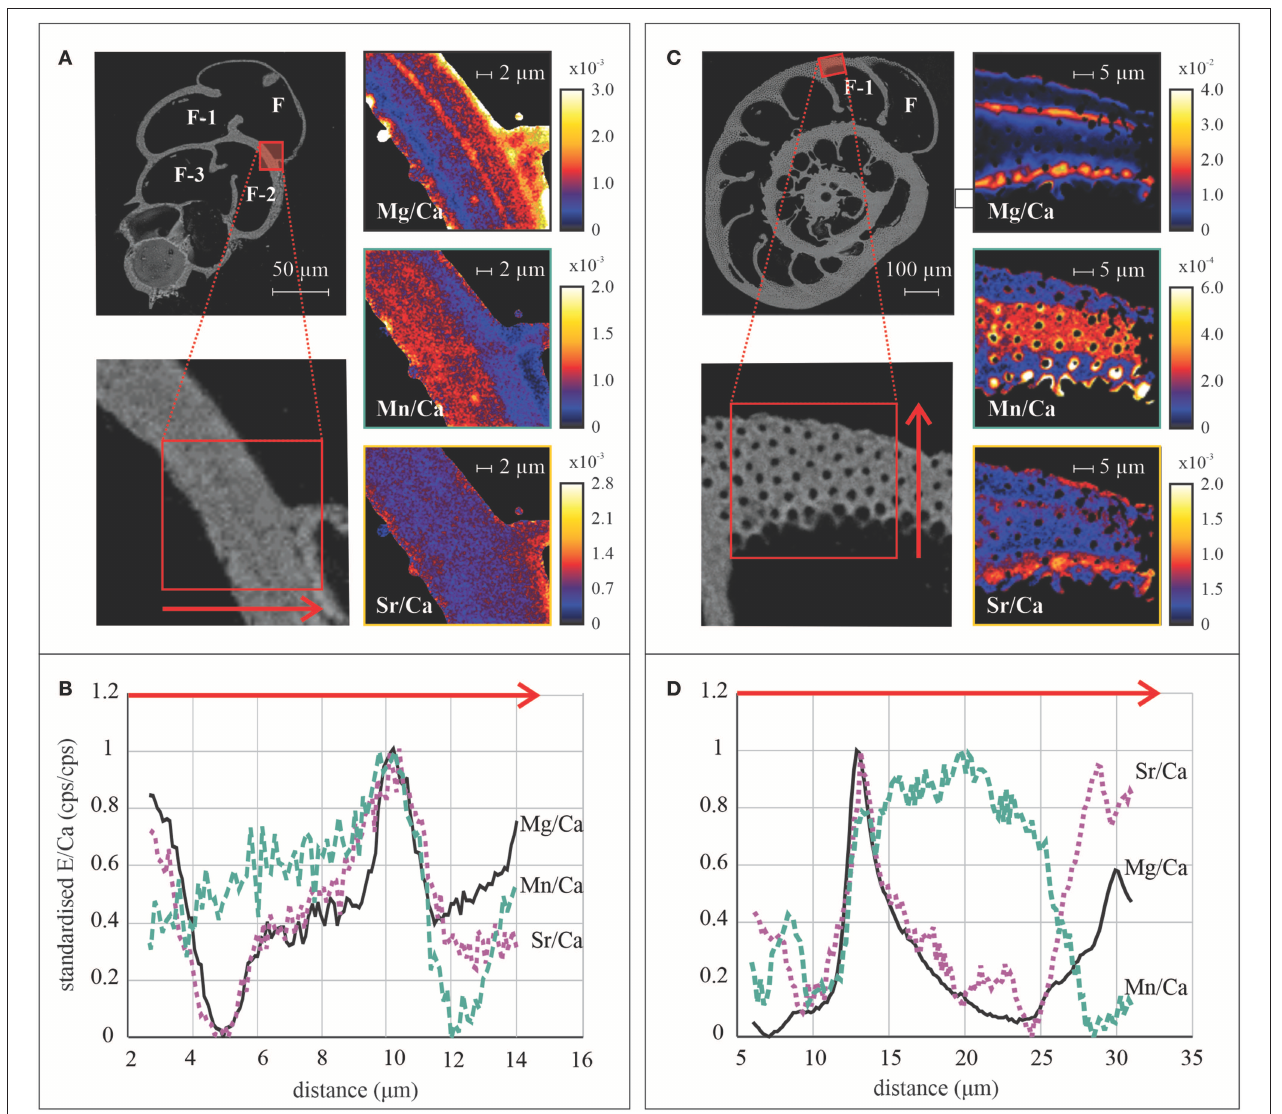
FIGURE 8 | Examples of distribution and transect profiles of elements acquired by nanoSIMS in tests of Bulimina marginata (A,B) and Amphistegina lessonii (C,D) from Aq10. The top panels show SEM overview picture of specimen and a close-up of area of interest with red rectangle of mapping area and arrow of transect analysis of B. marginata (A) and A. lessonii (C) . Element distribution maps of Mg/Ca, Mn/Ca, and Sr/Ca are in cps/cps. The lower panels show the distribution profile of normalized Mg/Ca (solid black line), Mn/Ca (dashed green line), and Sr/Ca (dotted purple line) over the transect from the inside of the test toward the outer side